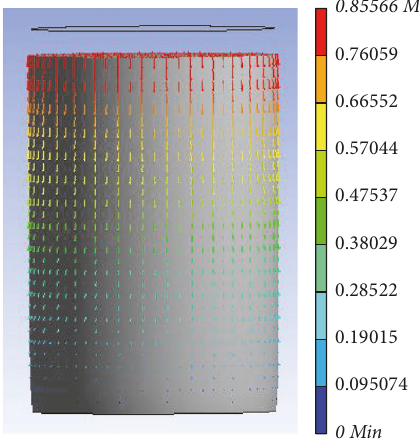
Figure 20: Linear deformation obtained.